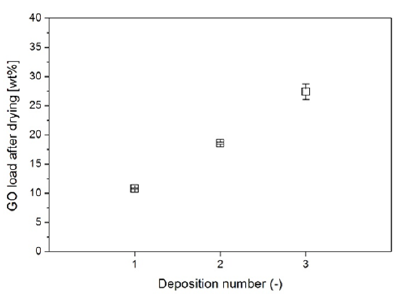
Figure 2. Average GO washcoat load as a function of the number of consecutive depositions (the standard deviation is the result of four replicated experiments).